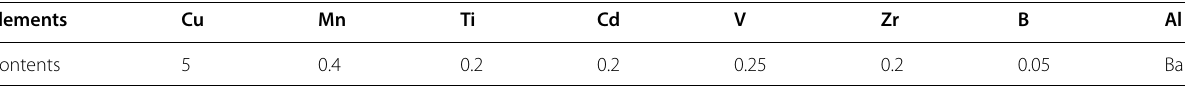
Table 1 Chemical composition of Al–Cu–Mn alloy (mass fraction, %)